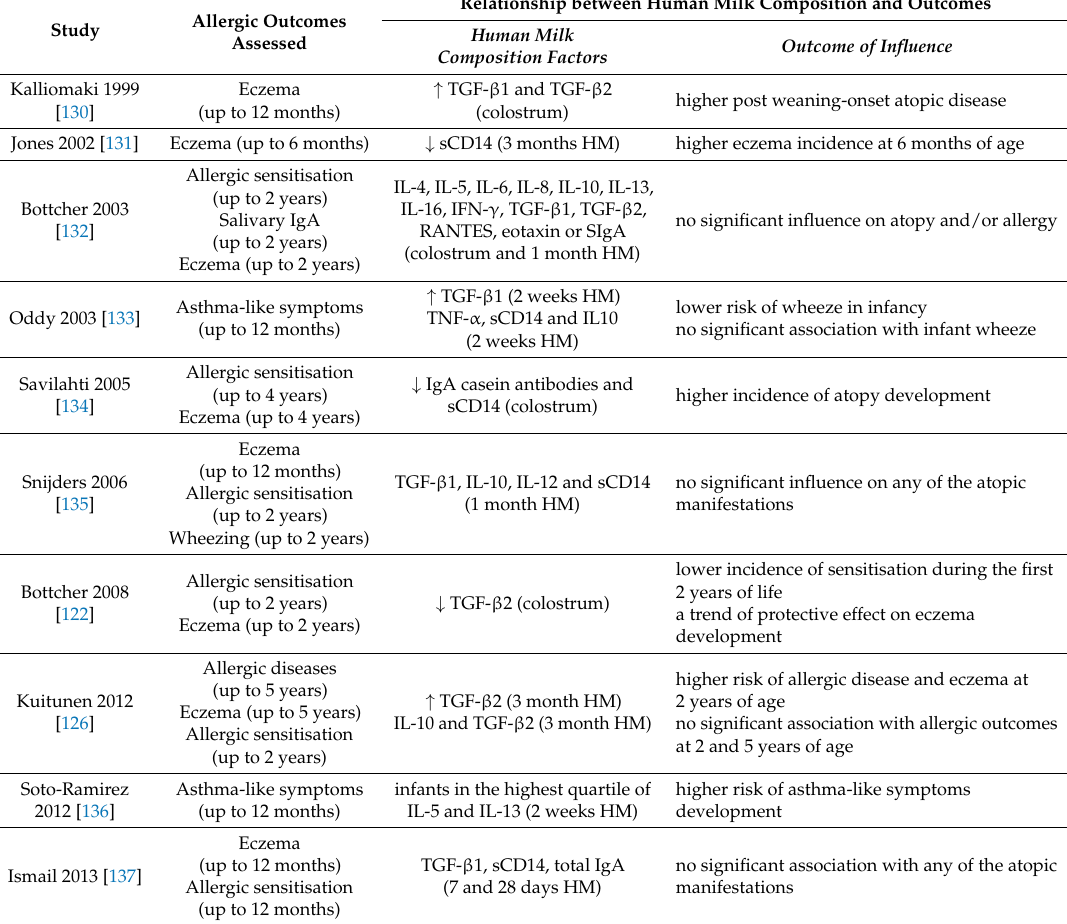
Table 2. Human milk immunological composition and allergy